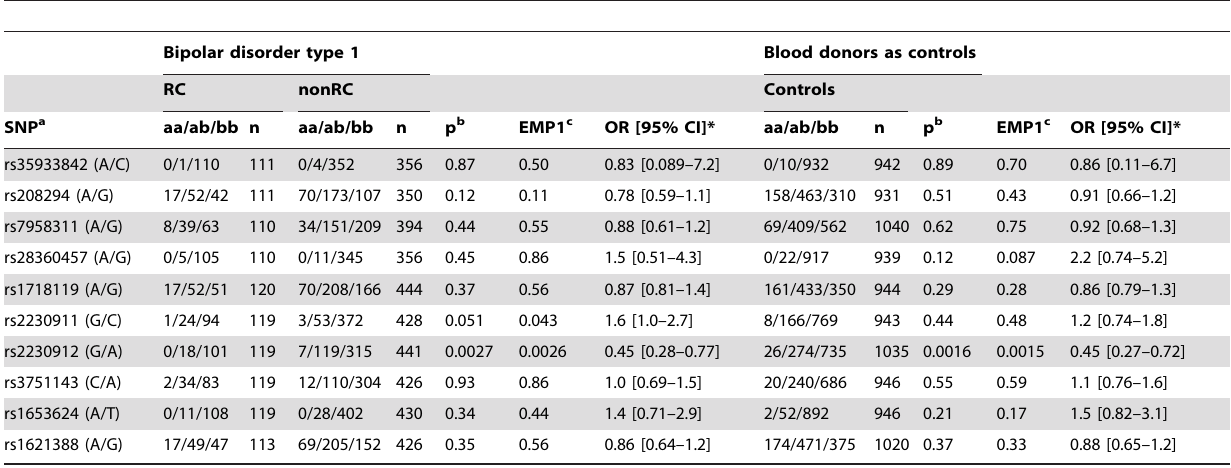
Table 3. Allelic associations for RC compared to nonRC bipolar patients and for RC compared to ABD controls in the P2RX7